Question: Based on the figure, does the quantity rise or fall?
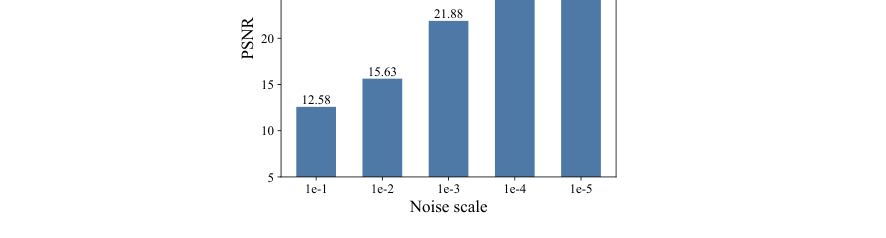
Answer: increasing